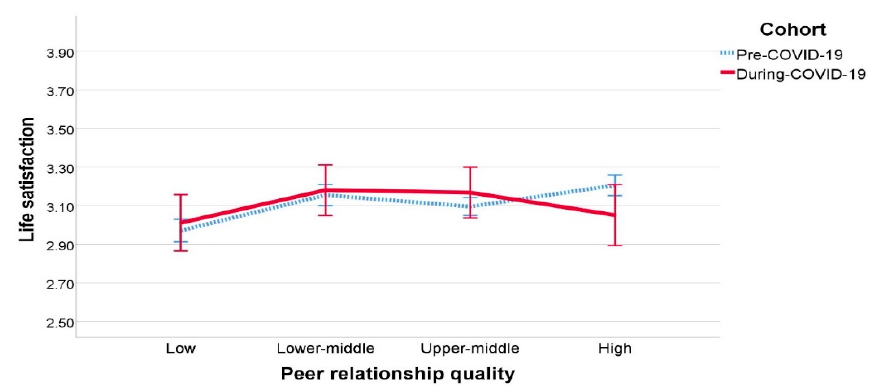
Figure 1. Estimated average values of life satisfaction by cohorts and peer relationship quality. Note. Covariates: perceived parenting style = 3.3083, academic engagement = 2.7203; bars represent 95% confidence intervals.